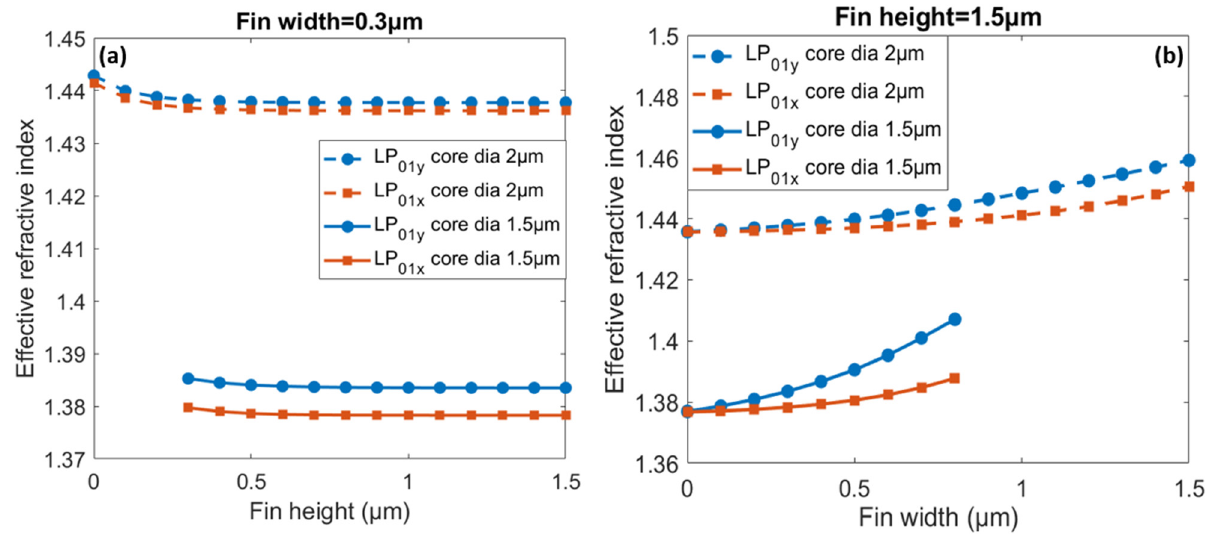
Figure 3. ( a ) Effective refractive index variation with fin height, h , for fin width of 0.3 µm. ( b ) Effective refractive index variation with fin width, w , for fin height of 1.5 µm and core diameters of 1.5 and 2 µm, for LP 01x and LP 01y modes.